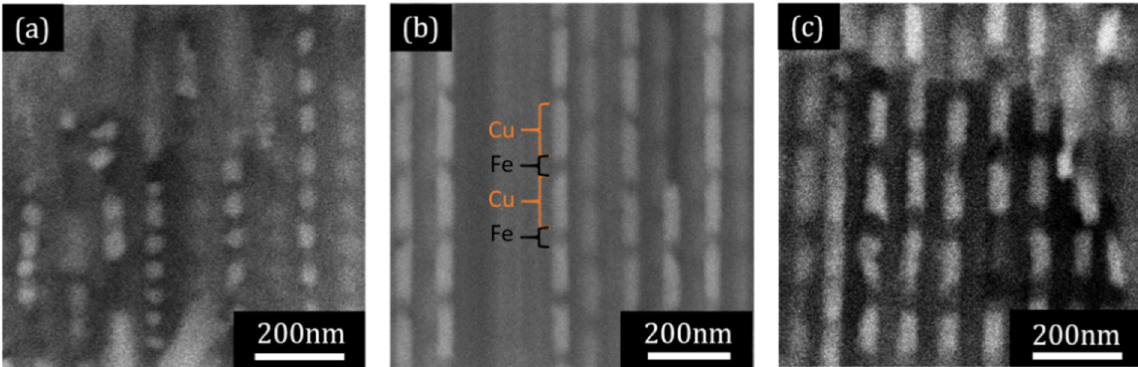
Figure 2. SEM cross-sectional views of multilayered Fe/Cu NWs embedded in AAO templates, exhibiting average Cu lengths of ( a ) 60 ± 7 nm and ( b , c ) 120 ± 5 nm and Fe lengths of ( a ) 20 ± 5 nm, ( b ) 30 ± 3 nm, and ( c ) 60 ± 8 nm.